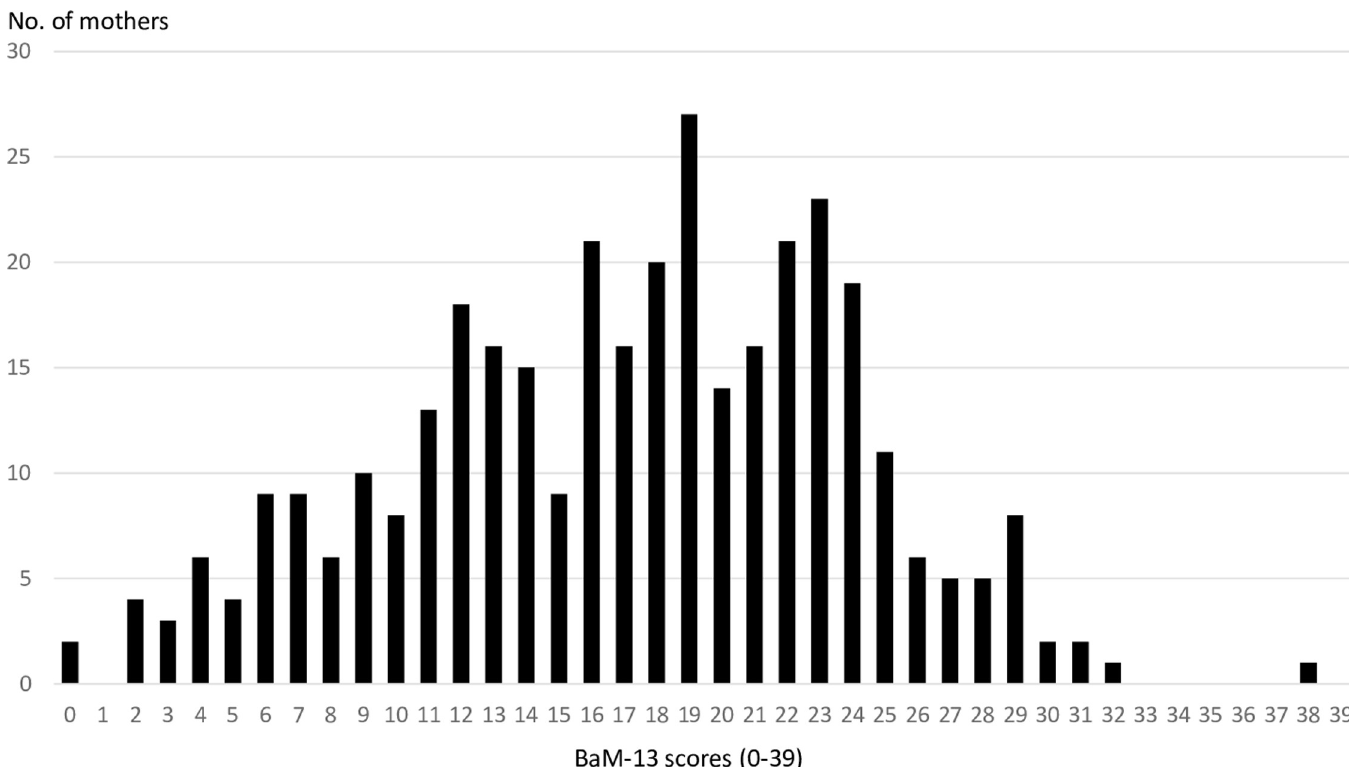
Fig 1. Distribution of BaM-13 scores � among 350 Korean women with young children. BaM-13, 13-item Being a Mother scale. � Higher scores indicate less satisfaction with the experience of motherhood. Table 2 lists the percentages of scores for each item, the percentages of those who gave scores of 2 or 3 points for each item, and the mean (SD) scores. The item for which the highest percentage of participants gave a score of 2 or 3 points was item 2 (“I have missed the life I had before I became pregnant with this baby/toddler”), with 80.8% of the total participants agree- ing with the statement. The item with the next-highest proportion of participants citing agree- ment was item 12 (“I worry I am not as good as other mothers”), at 66.5%. This was followed